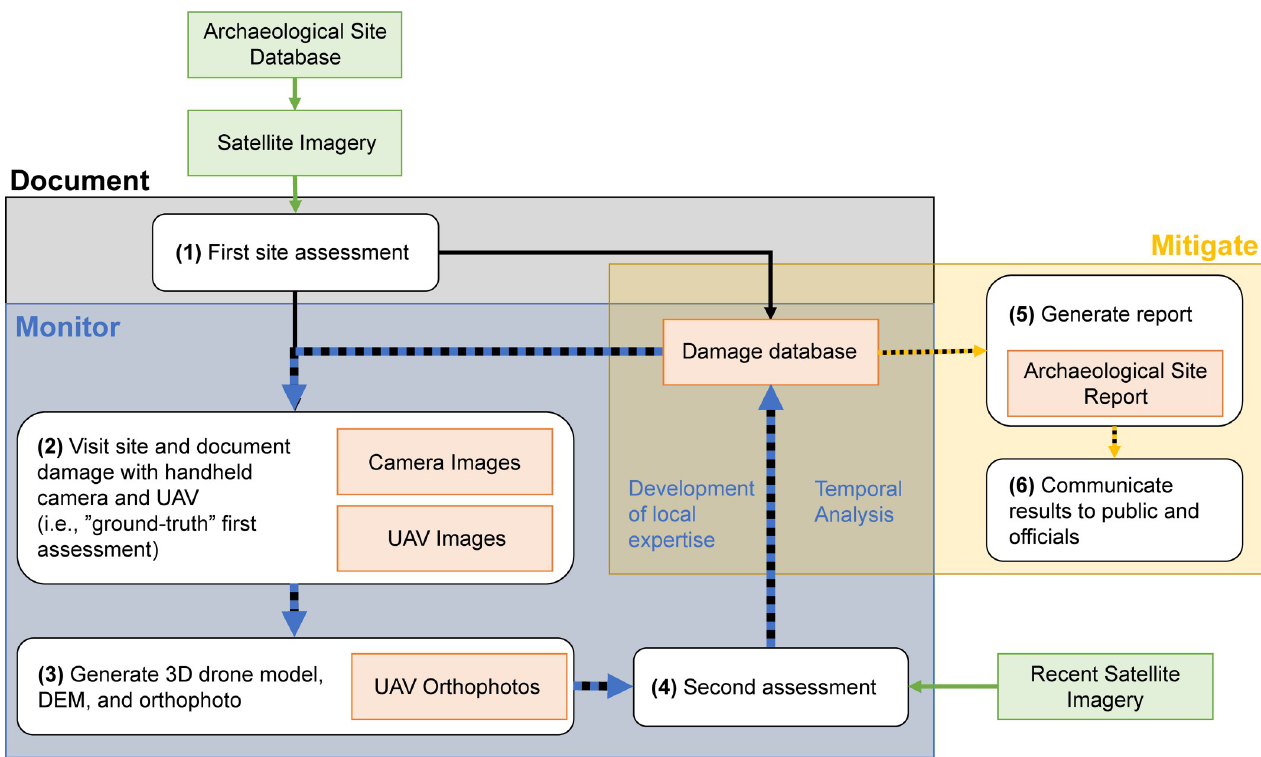
Fig 2. Graphic of monitoring objectives and workflow. The three main objectives are displayed in different colour semi-transparent boxes. Numbered white boxes indicate each workflow step. Green boxes are digital inputs to the workflow and orange boxes are digital data products. Dashed blue arrows specify the iterative processes in the workflow. Dashed yellow lines indicate site protection